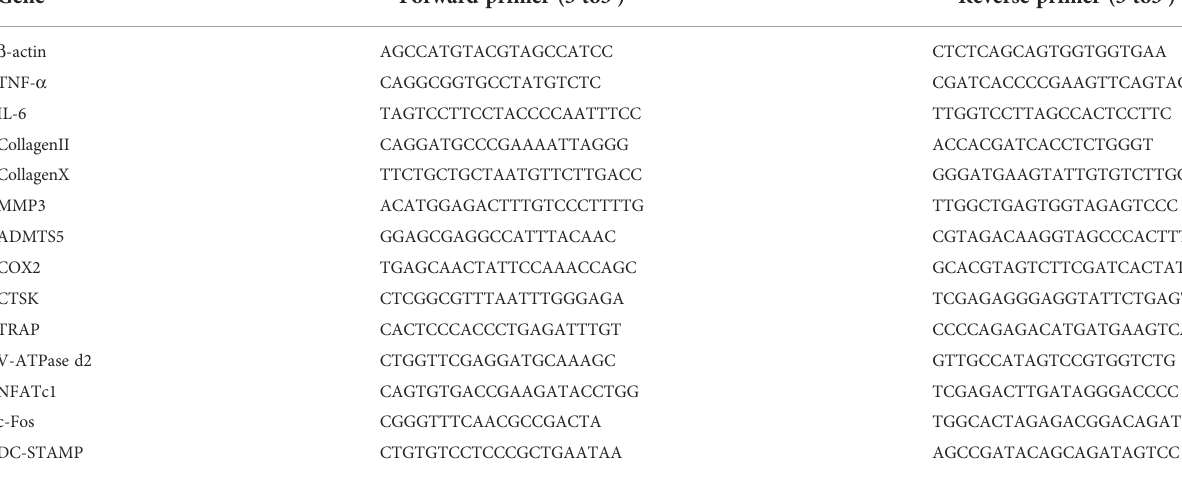
TABLE 1 Primer sequences for